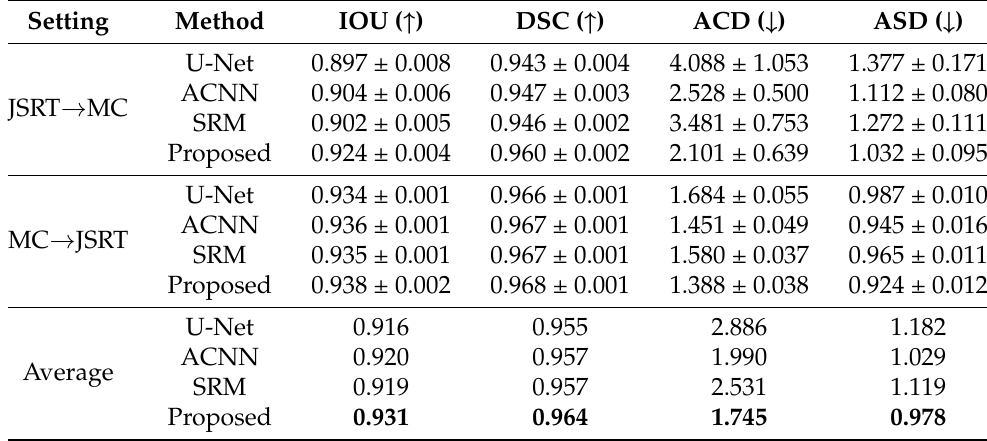
Table 6. Comparison of the domain robustness on lung segmentation. The best result on averaging over two settings is shown in